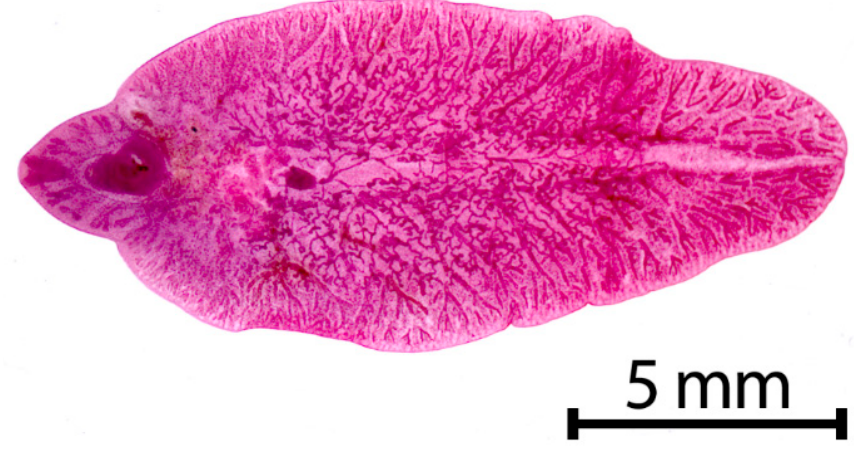
Figure 1. Adult stage of Fasciola hepatica .